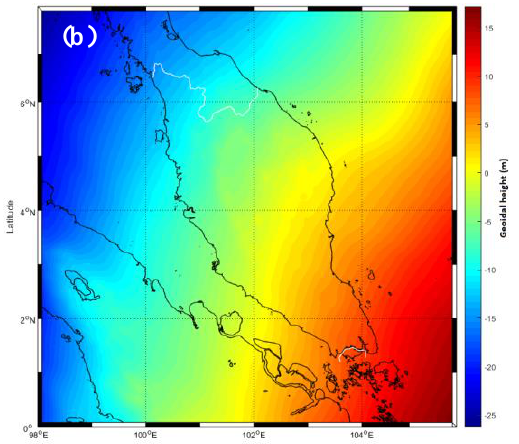
Figure 7. Approximate geoid height from strategy 1(a) and strategy 2 (b)